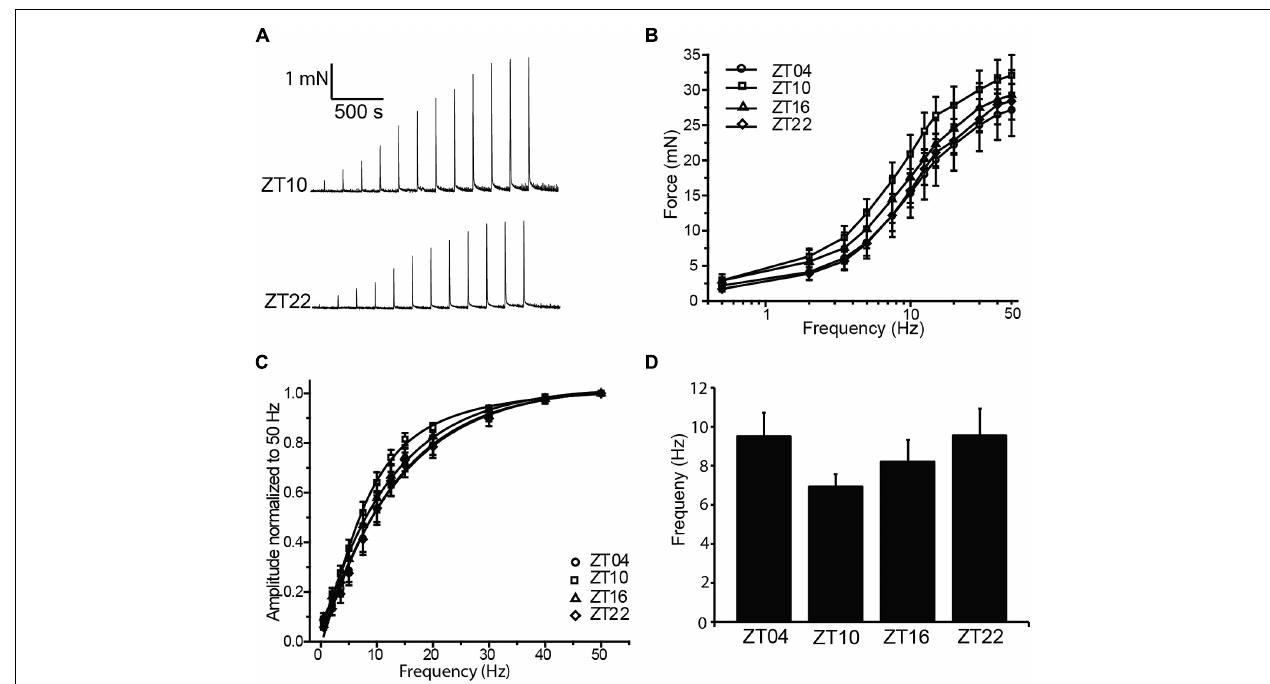
FIGURE 3 | Nerve-evoked (EFS) contractions are not different between timepoints. (A) Representative EFS-evoked contractions at ZT10 and ZT22. (B) EFS-evoked contractions, elicited by 0–50 Hz stimulation, are not different between timepoints. (C) EFS-evoked amplitudes normalized to